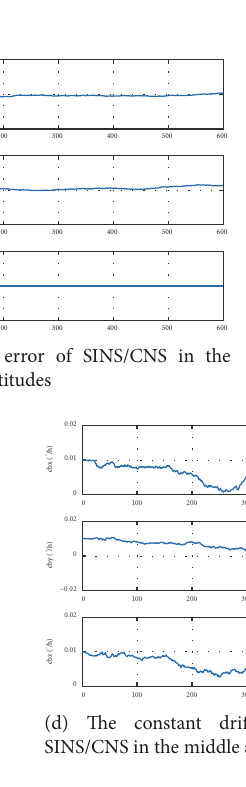
Based on the error state equation of SINS and the system state vector of SINS/CNS integrated navigation system,